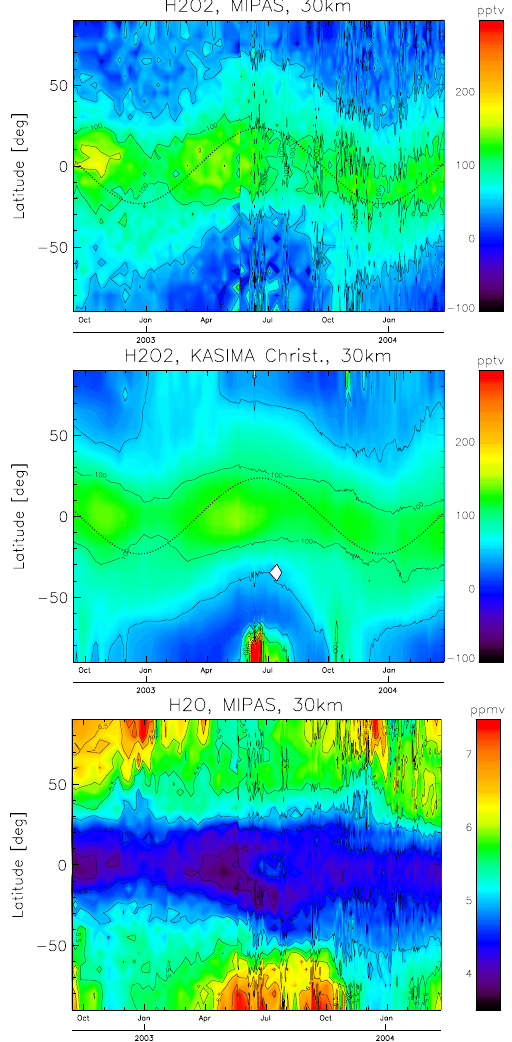
Fig. 10. Temporal evolution of the daily zonal means of the vol- ume mixing ratio in 30km of: (top) H 2 O 2 as observed by MIPAS; (middle) H 2 O 2 modeled by KASIMA with reaction rate constant from Christensen et al. (2002) for R1; vmr on MIPAS geolocations with MIPAS A applied; Additionally for H 2 O 2 the latitude where the sun reaches zenith position for that day is shown (black dotted) (bottom) H 2 O as observed by